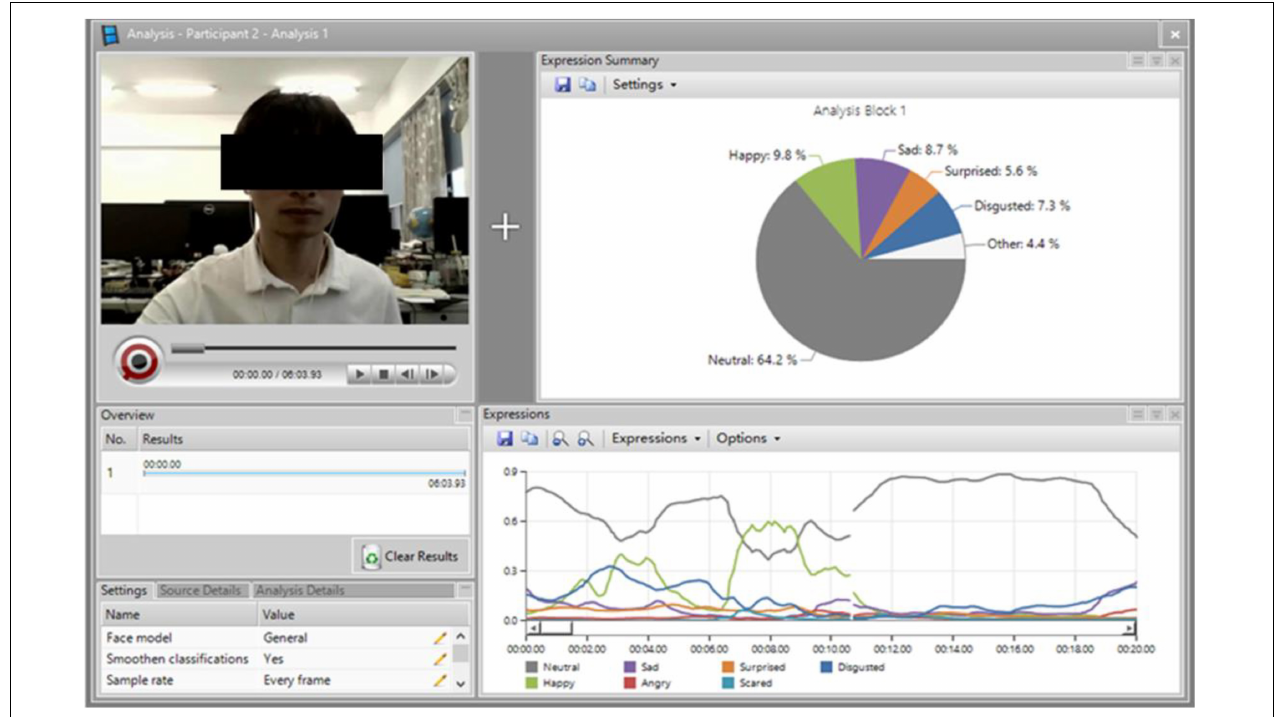
FIGURE 1 | Emotional analysis of a participant.